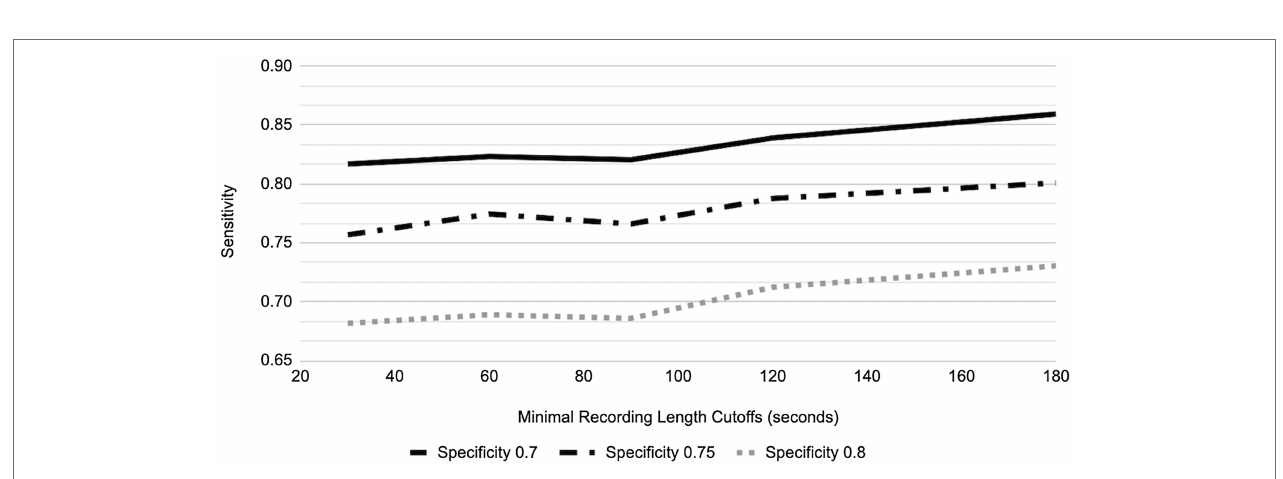
FIGURE 5 | GAD AUC Performance Comparing LSTM with Transformer Methodology for Both GP and GN.